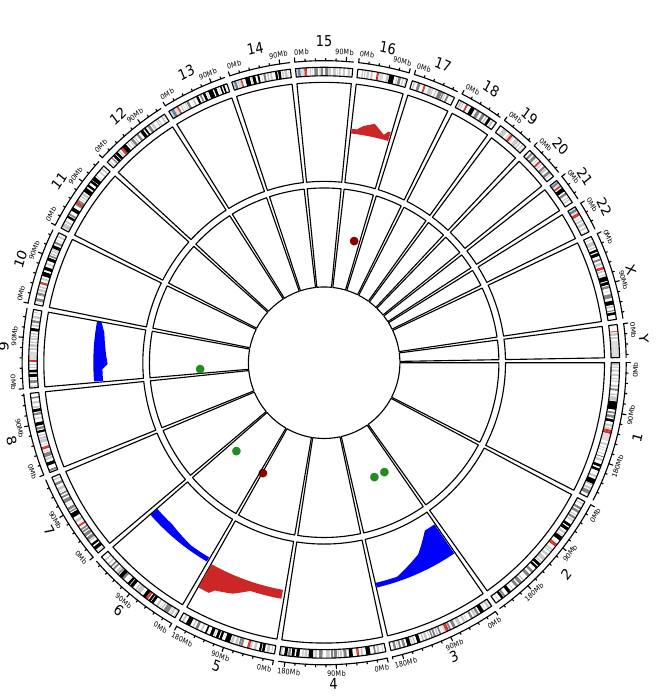
Figure 2. Circos Plot showing the correlation of CNAs and gene expression from Oncomine data. The periphery circle represents regions of Copy Number Aberrations along the genome per chromosome. Red represents copy number gains and blue copy number losses. The inner circle contains genes with concomitant alteration in gene expression. Green dots represents down-regulated genes and red up-regulated